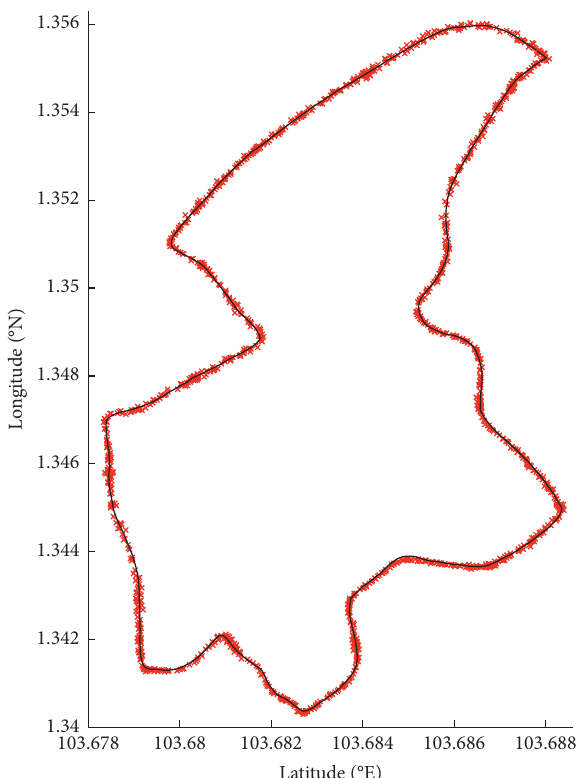
Figure 15: Scatter plot of all xi;t+1, with a fitted line representing the average route taken by the buses.